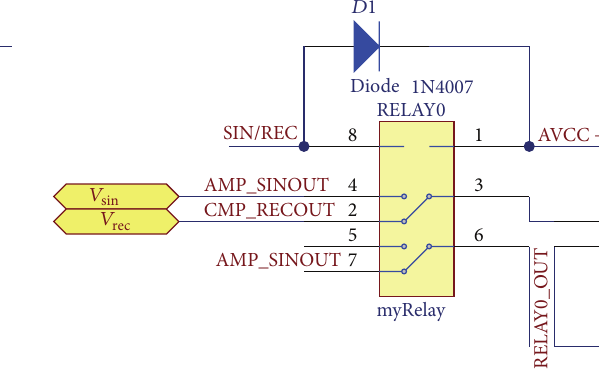
Figure 12: The circuit of relay controller.